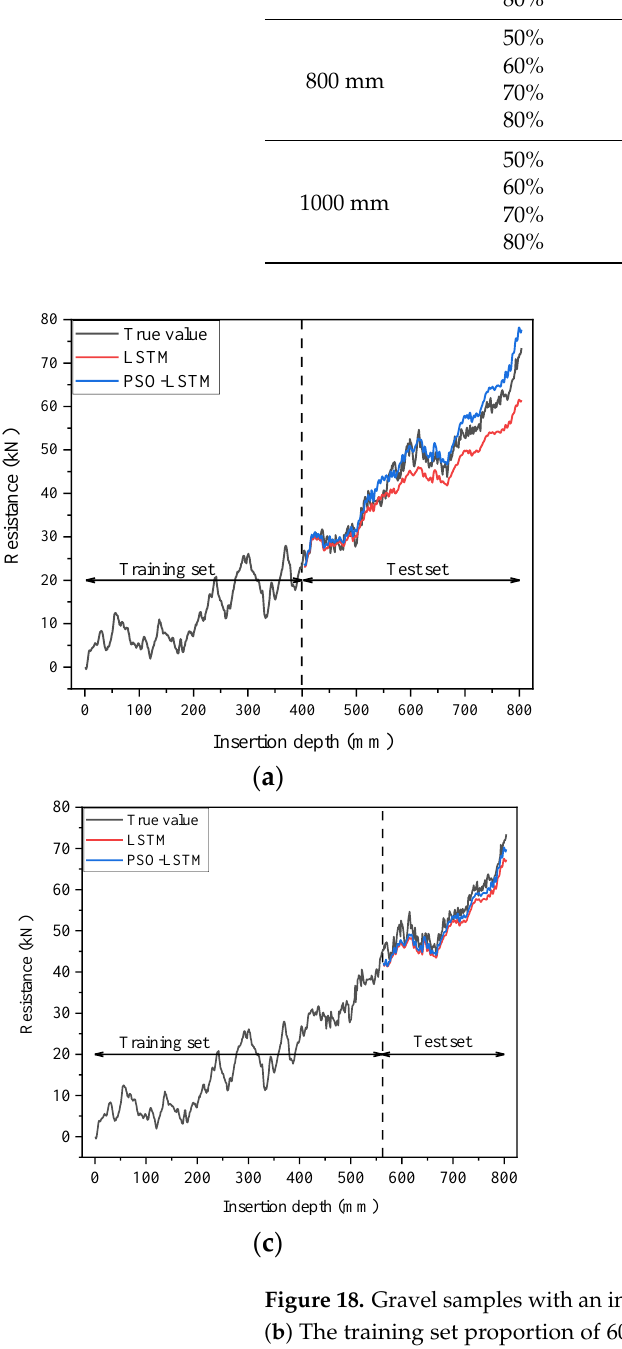
Figure 18. Gravel samples with an insertion depth of 800 mm. ( a ) The training set proportion of 50%; ( b ) The training set proportion of 60%; ( c ) The training set proportion of 70%; ( d ) The training set proportion of 80%.